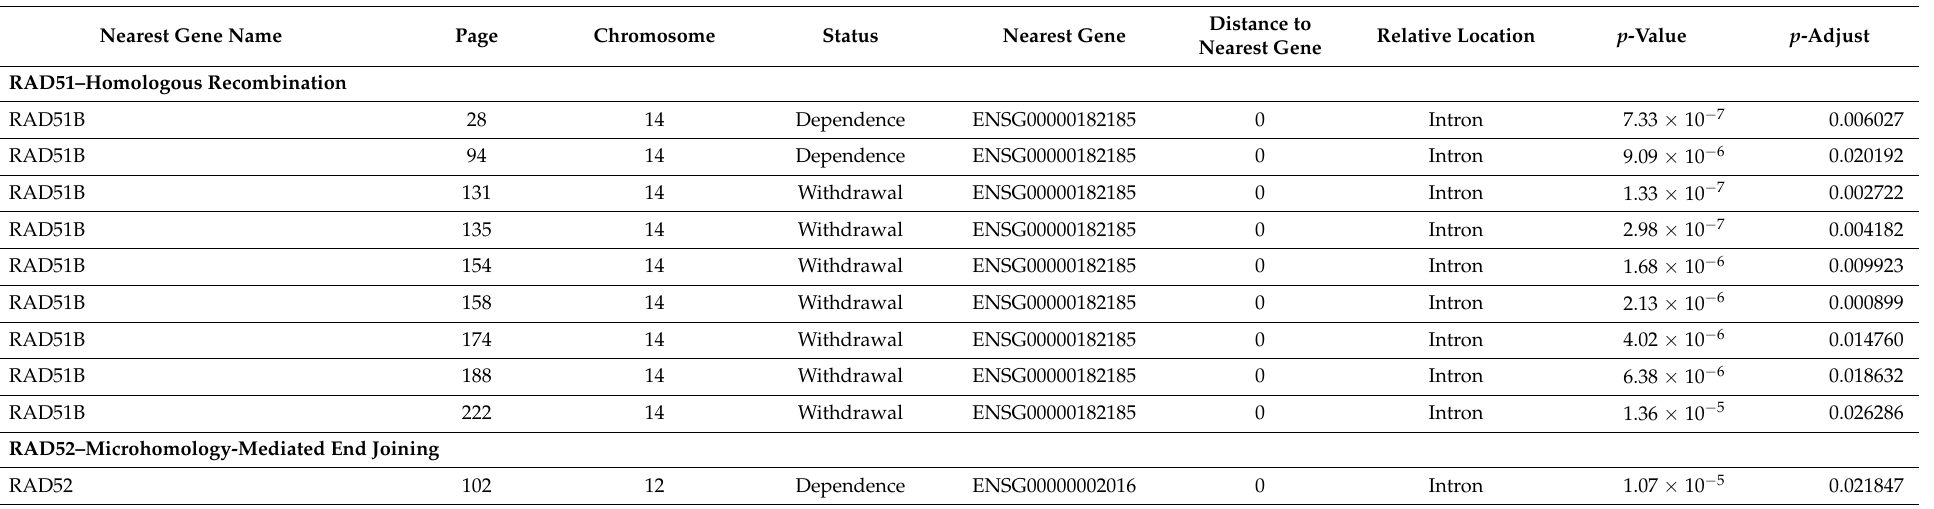
Table 13. EWAS Hits on RAD51/52 Recombinase; Data from Schrott